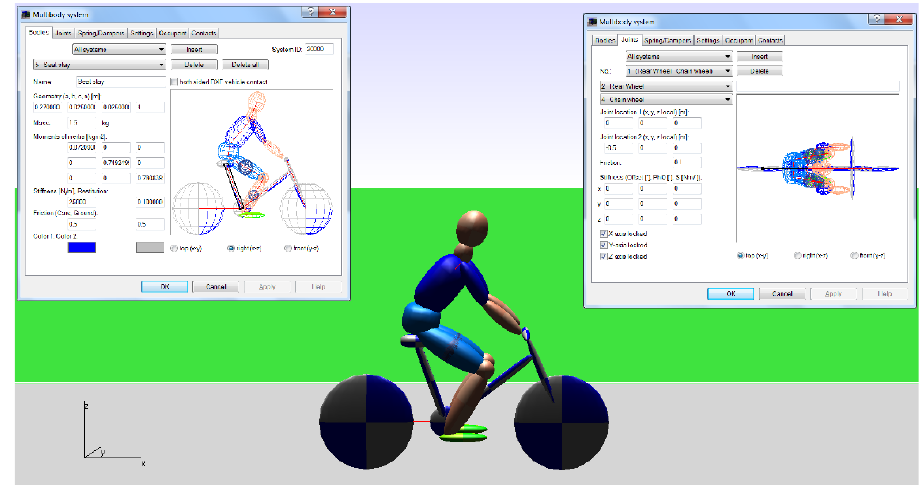
Figure 1. Program PC CRASH 8.1 car model.